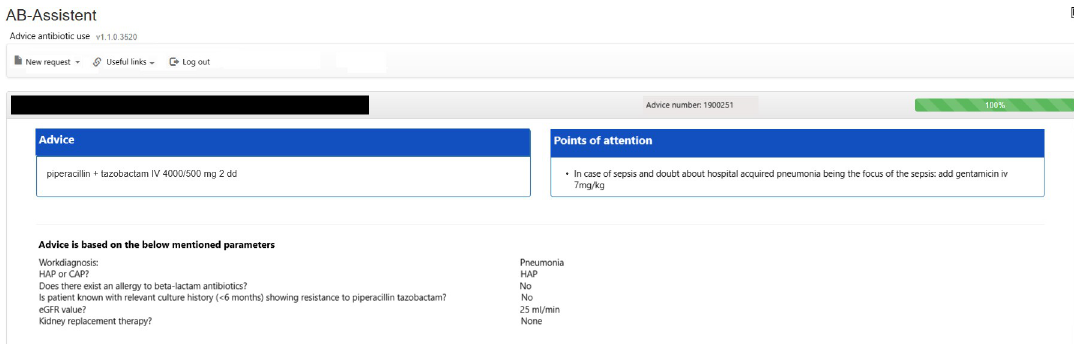
Fig 4. Final screen of the CDSS for empirical antibiotic therapy with a patient specific antibiotic